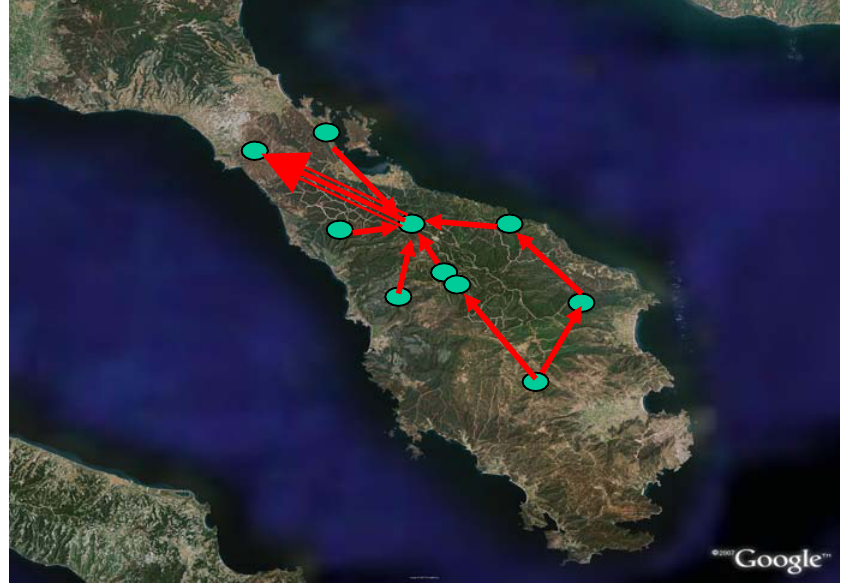
Figure 2. Location and links of terminals – optical cameras (Sithonia,